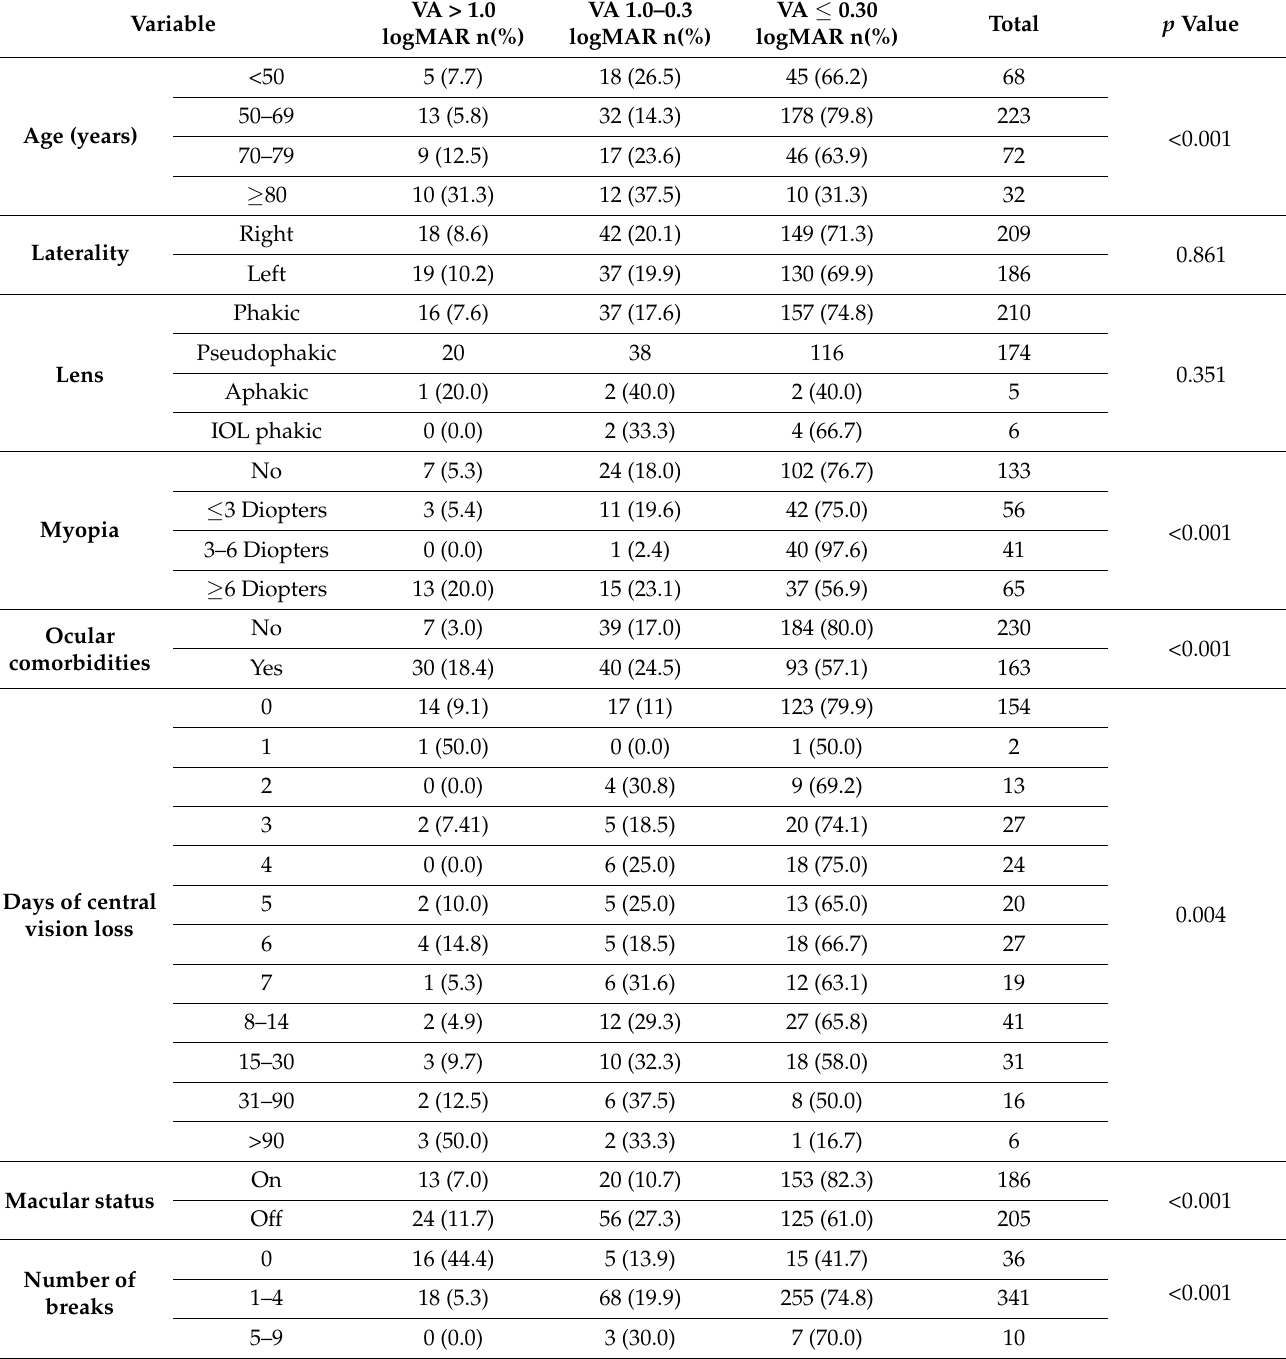
Table 7. Univariate analysis of the variables used for final post-operative VA analysis. Univariate analysis of qualitative variables that might be associated with final post-operative VA in patients not suffering redetachment was performed using chi-square tests. The number and percentage of cases of VA > 0.3 logMAR and VA ≤ 0.30 logMAR within each variable, as well as the total number for each variable, were indicated. Chi-square p values are shown, considering p < 0.05 to be statistically